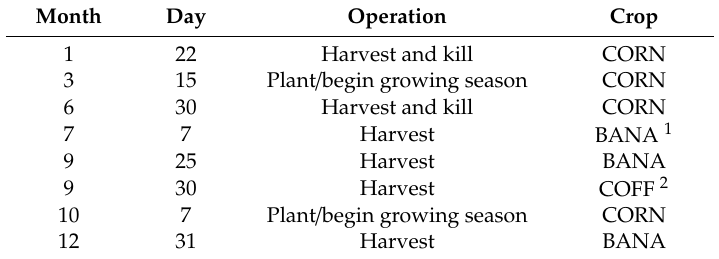
Table A2. Planting and harvesting schedule for the irrigated banana, co ff ee, and maize to irrigated banana and co ff ee to irrigated banana, co ff ee, and maize trajectory in SWAT + decision table.